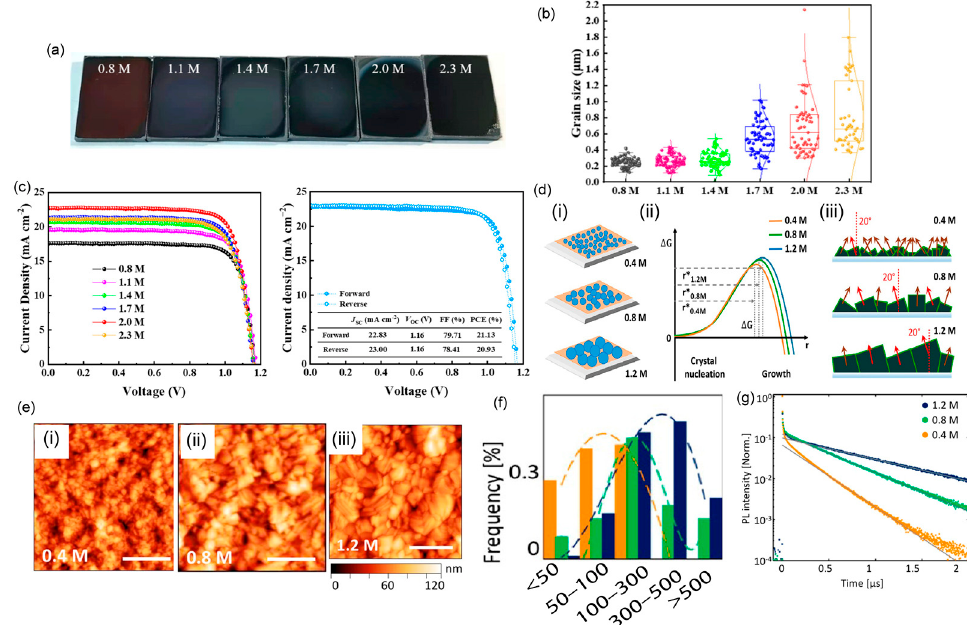
Figure 6. Effect of precursor concentration. ( a ) Photographs and ( b ) grain size distribution of perovskite films with different precursor concentrations. ( c ) J − V curve for different precursor concentrations and forward and reverse scans of J − V curve for champion device for triple-cation perovskite films [99]. ( d ) ( i ) Schematic of grain growth, ( ii ) nucleation and Gibbs free energy relation with different concentrations as a function of critical radius, r* , and ( iii ) effect of grain orientation influenced by grain growth process for different precursor concentrations of triple-cation perovskite films. ( e ) AFM images (the scale bar is 1 µ m) of the films prepared with different concentrations; ( i ) 0.4, ( ii ) 0.8, and ( iii ) 1.2 M of the mixed-ion perovskite. ( f ) Grain size distribution for different concentrations of precursor solution (0.4, 0.8 and 1.2 M) and ( g ) time-resolved PL for different precursor concentrations [102]. Reprinted with